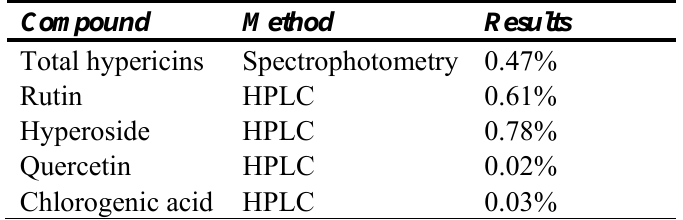
Table 1. Chemical analysis of St. John’s Wort methanolic extract.